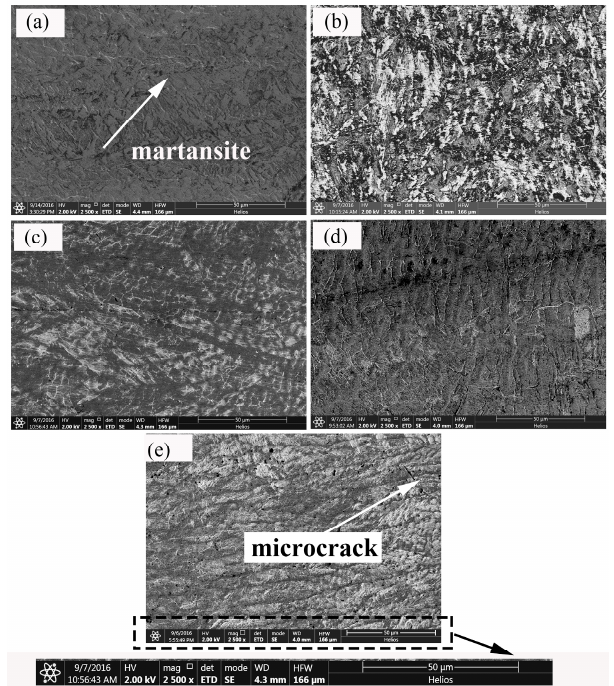
Figure 8. Comparison of the Scanning Electron Microscopy (SEM) morphologies of center seam with different welding speed: ( a ) 0.4m/min; ( b ) 0.6 m/min; ( c ) 0.8 m/min; ( d ) 1.0 m/min; ( e ) 1.2 m/min.